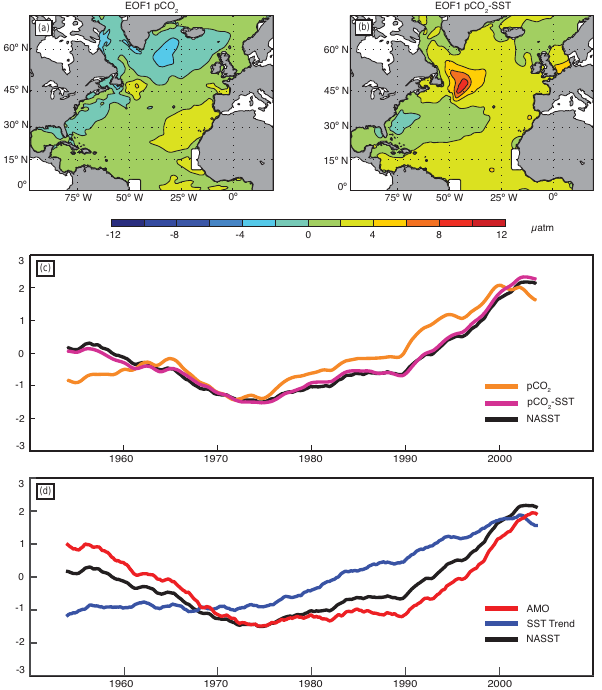
Figure 1. (a) EOF1 of total p CO 2 (µatm) and (b) EOF1 of p CO 2 - SST (µatm), explaining 18 and 38% of total variance, respec- tively. (c) PC1- p CO 2 (orange); PC1- p CO 2 -SST (pink); and area- weighted, basin-averaged standardized North Atlantic SST time se- ries (black). (d) Area-weighted, basin-averaged (0–70 ◦ N, 98 ◦ W– 19.5 ◦ E) North Atlantic SST from Had1SST (black); global area- weighted SST regressed onto North Atlantic SST (blue); and AMO index created by subtracting the global regression from the North Atlantic SST (red). All indices are standardized by 1 σ . Time series smoothed with a 121-month box smoother. Two small coastal areas off Africa and South America were excluded in (a) and (b) due to the presence of localized, anomalously strong upwelling in the early 1960s that precluded elucidation of the large-scale